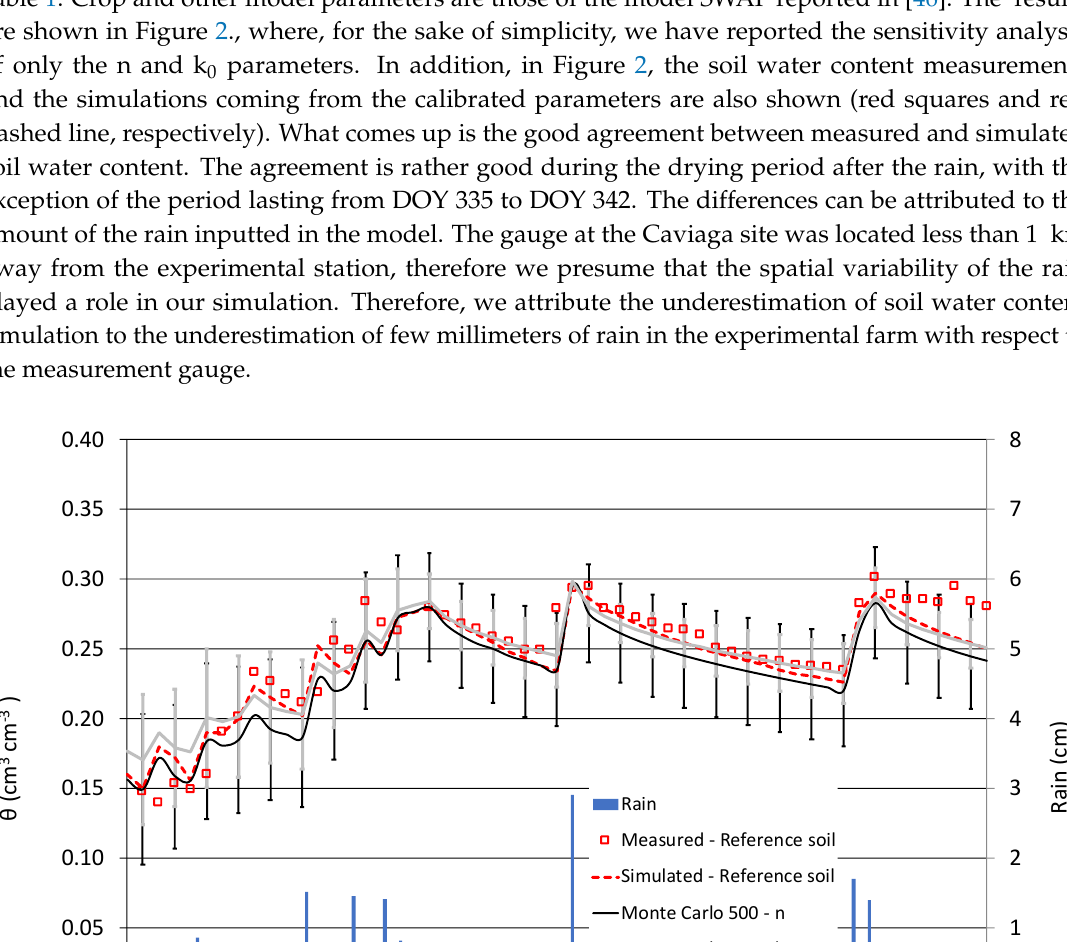
Table 2. Statistics of pedotransfer functions (PTF)s.